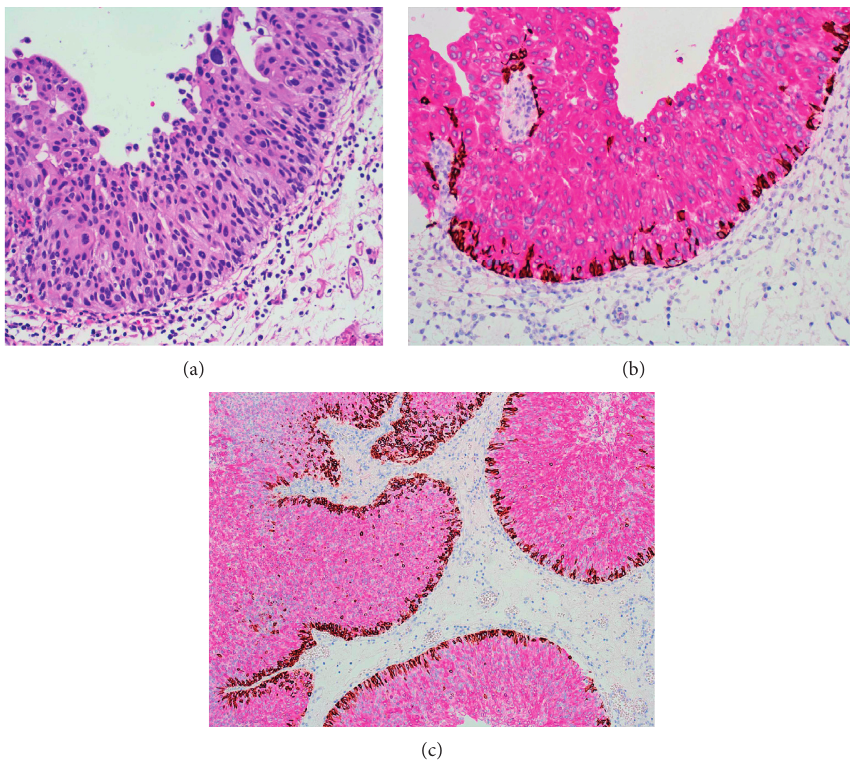
Figure 3: (a) High-grade papillary urothelial carcinoma. (b) High-grade papillary urothelial carcinoma with diffuse full-thickness staining for CK20 and presence of basal layer as demonstrated by CK5/6 staining. (c) High-grade urothelial carcinoma revealing the diffuse presence of basal cells and full-thickness staining for CK20.